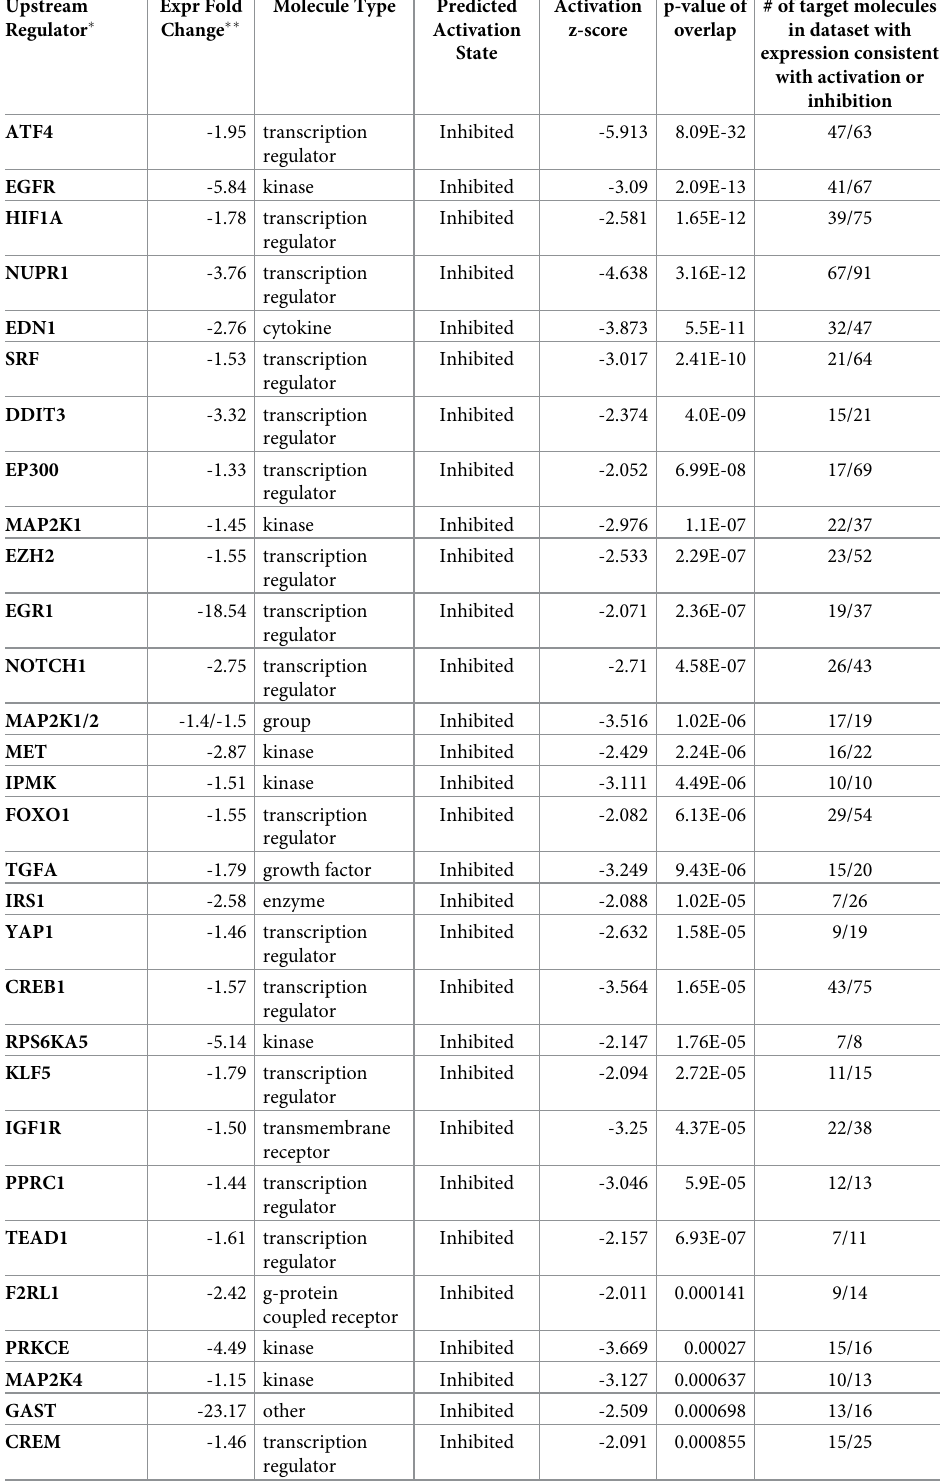
Table 4. Upstream regulators predicted for AGS-EBV tumors vs cell